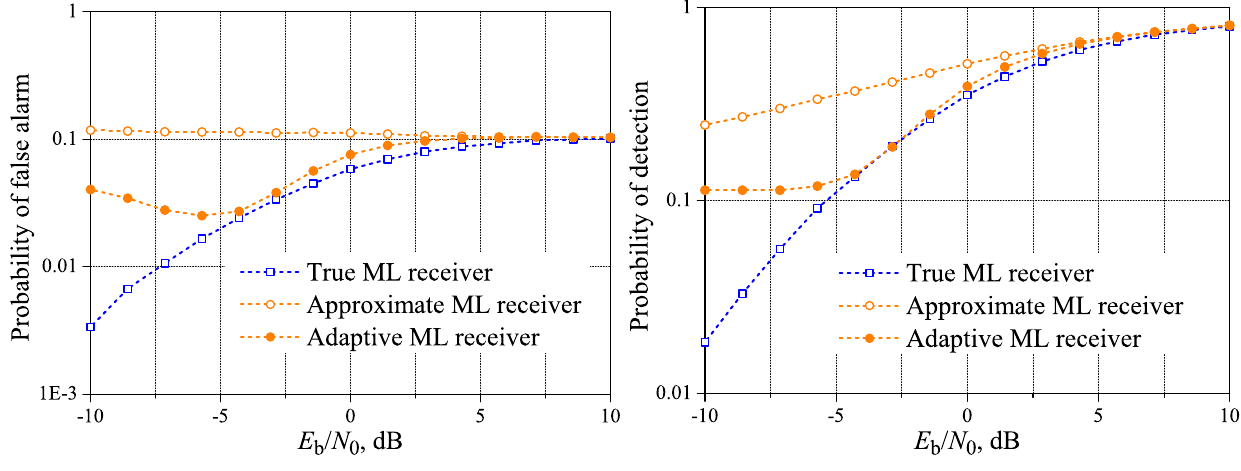
Figure 11. Performances of the improved ML (adaptive), true ML and approximate ML receiver for: M = 3 and K = 1 (top) ; and M = 3 and K = 3 ( bottom ).